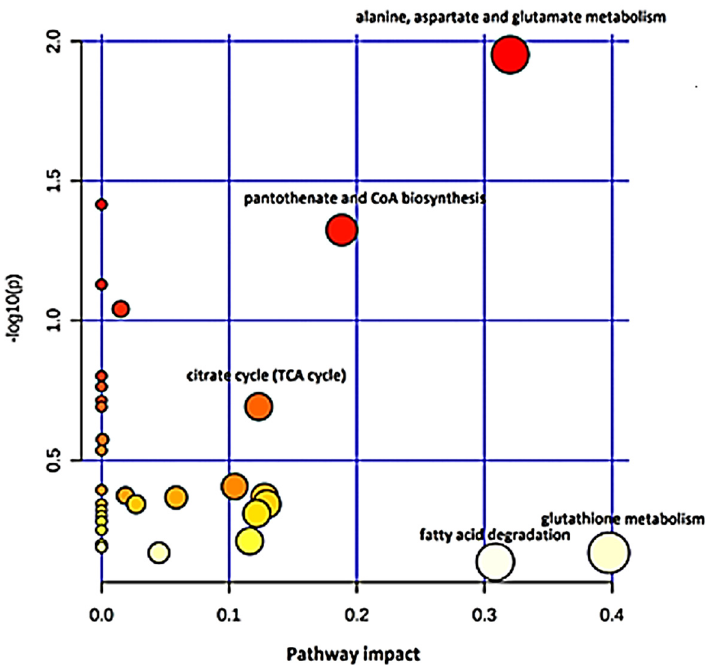
Figure 4. Overview of pathway topology analysis: MetPA-computed metabolic pathways. A visual representation of information showing all matched pathways according to the log p -values and impact scores (Table S3). Pathways are displayed according to their significance (pathway impact) indicating pathways with high impact to low impact (bright red to light yellow, respectively) active in H. roseonigra .